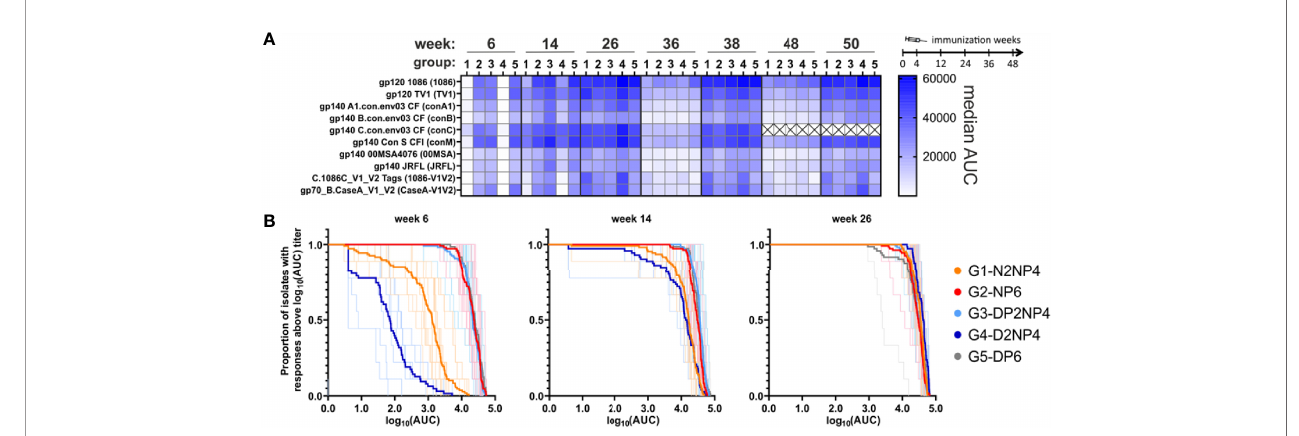
FIGURE 5 | Binding antibody multiplex assay of IgG in plasma samples. (A) Magnitude of response to the various readout antigens (abbreviations used further are de fi ned in brackets) measured as median AUC and indicated by color-intensity (scale on the right). ConC magnitudes were not determined for the late time-points (weeks 48 and 50; ×). (B) Magnitude-breadth plots of the overall IgG responses (log 10 -transformed AUC values of individual titration curves) towards the 9 readout antigens (excluding conC). Bold lines indicate overall group responses, while responses of individual monkeys are shown as thin lines.